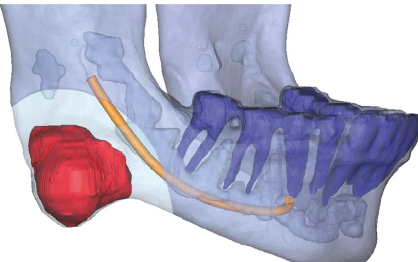
Figure 3: Virtual surgical plan allowing for 5 mm surgical bony margin surrounding the tumor, indicating overlap between surgical margin and mandibular canal.